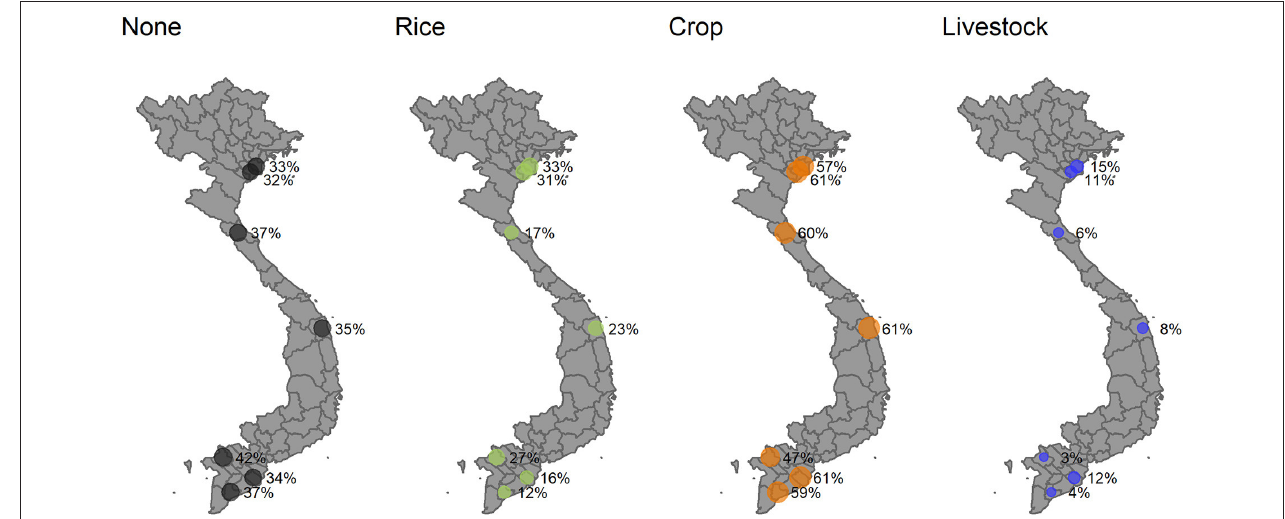
FIGURE 3 | Map showing the percent of respondents practicing agricultural adaptations in each surveyed